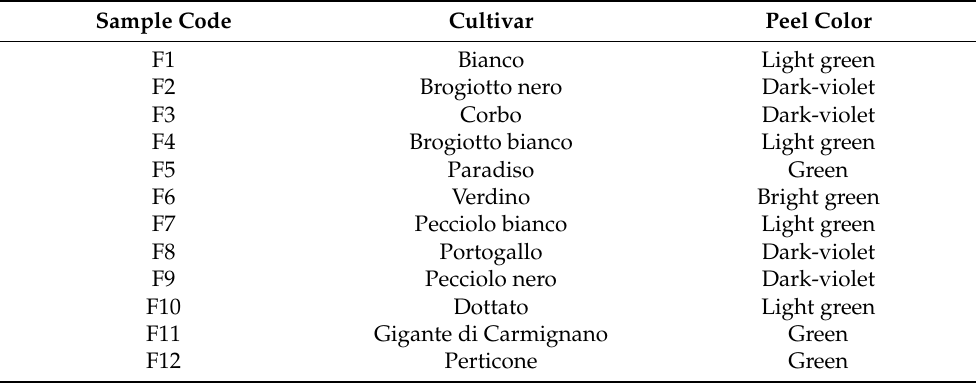
Table 3. Fig cultivars investigated in the present